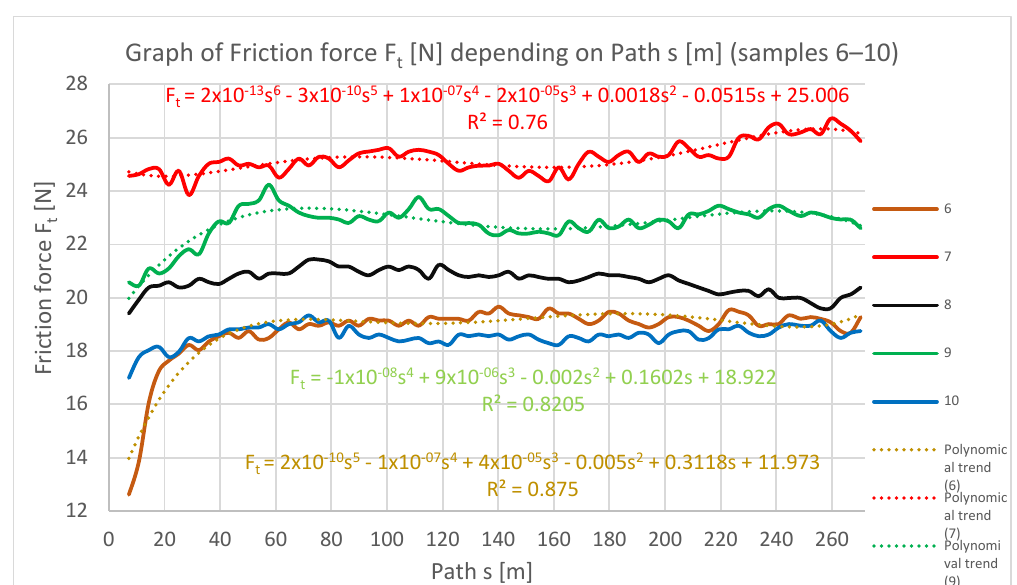
Figure 11. Plotted coefficient of friction depending on the path of Samples 6 – 10.